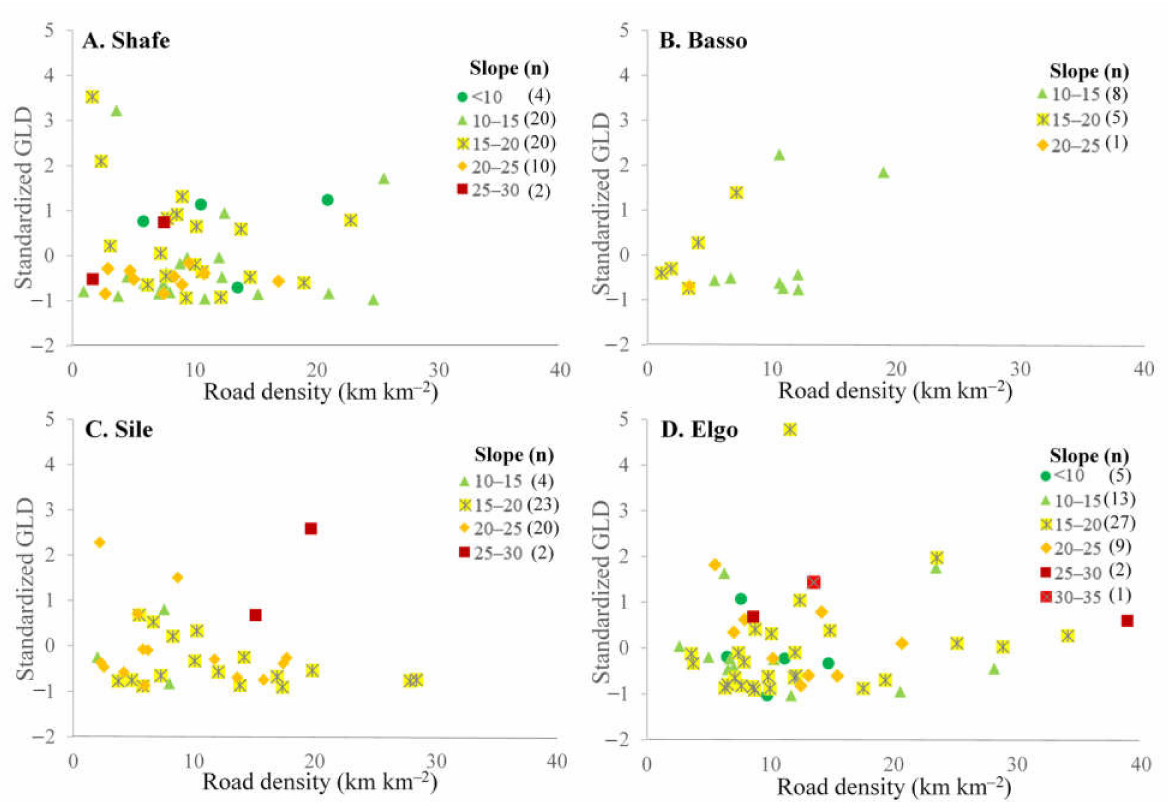
Figure A4. Relationships between population density for the year 2020 and GLD, for active gullies of each river catchment. Slope represents the mean slope angle (degree) of each sub-catchment and n represents the number of sub-catchments of each slope-angle class.